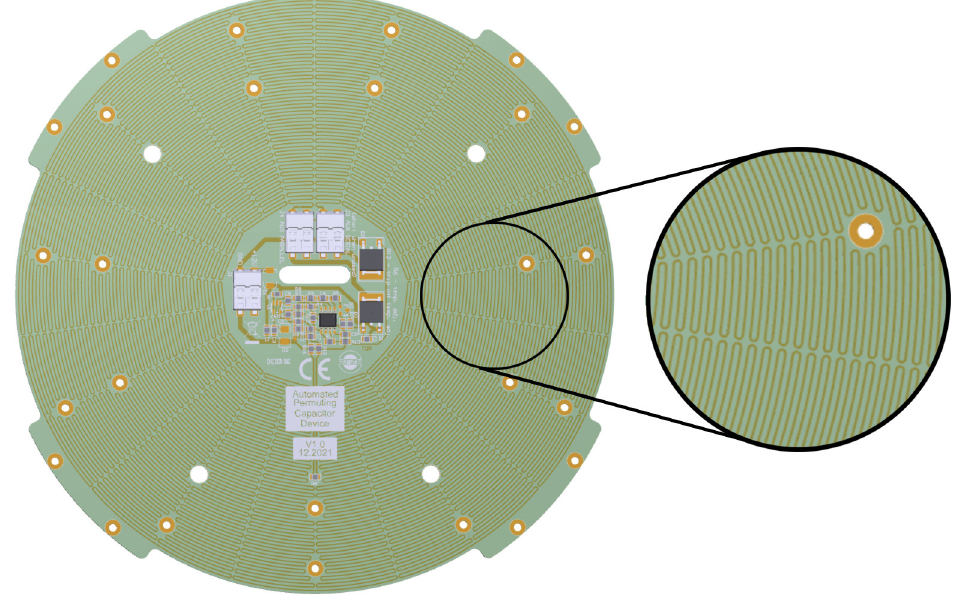
Figure 6. A PCB with integrated thermostat designed for use with the switched capacitor device.